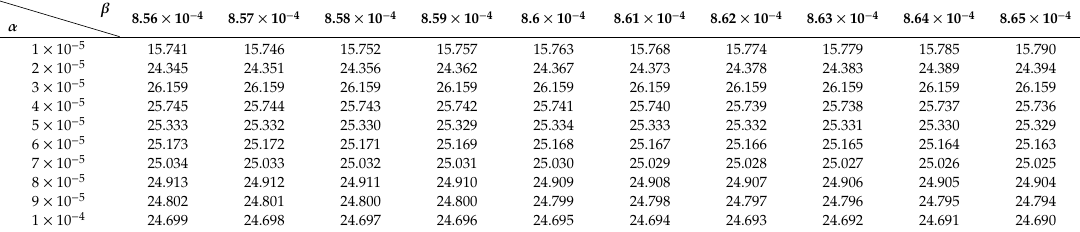
Table 2. IFs1 with di ff erent α , β corresponding to signal-to-noise ratio (SNR) data. α